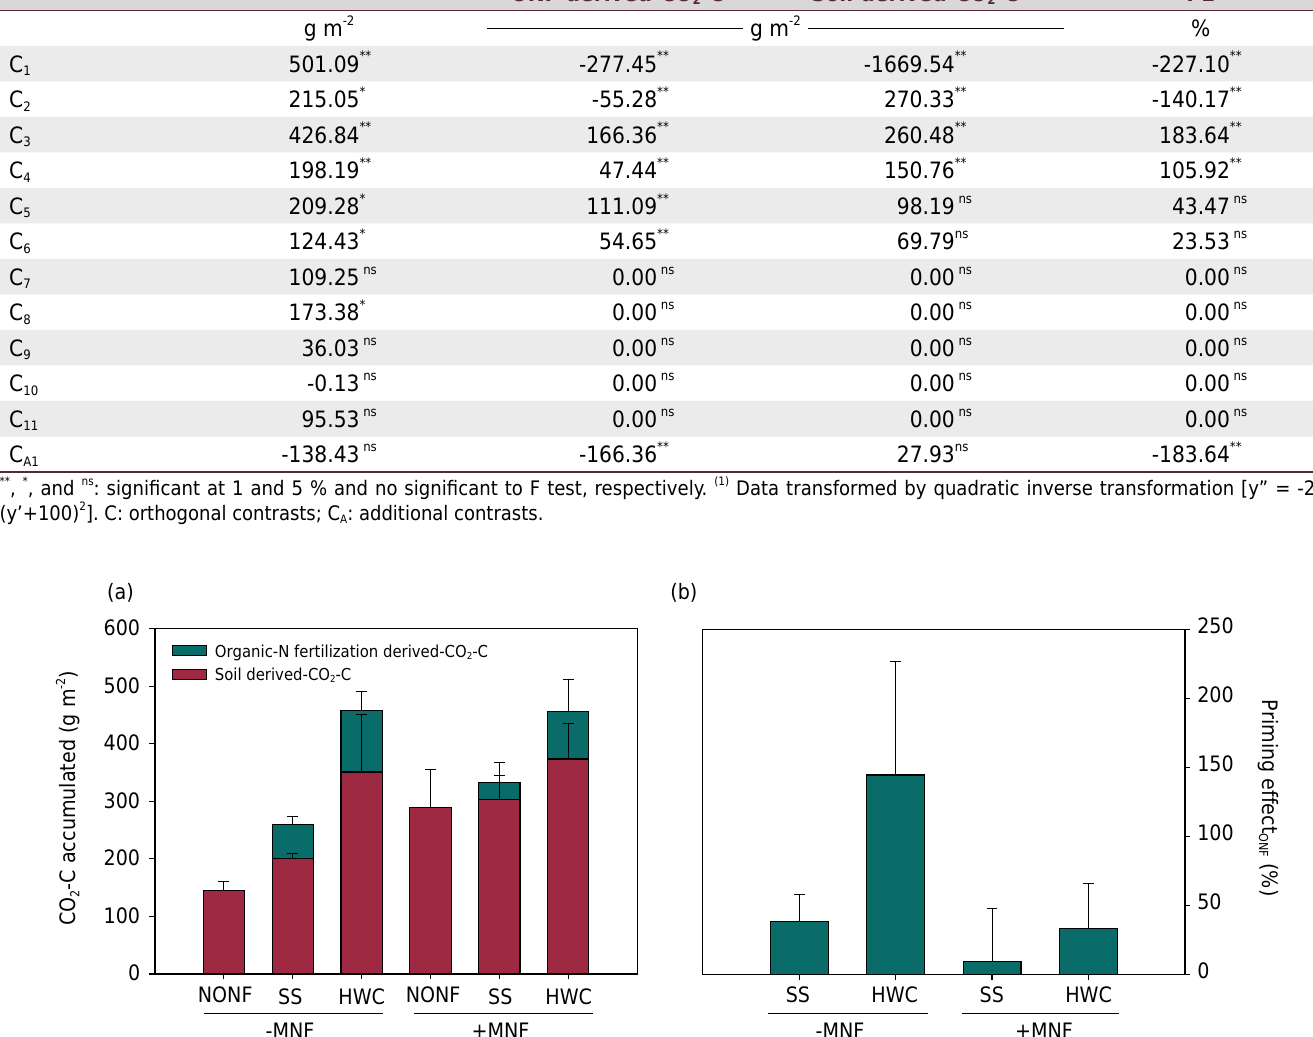
Table 4. Mean contrasts to total soil CO 2 -C accumulated and organic-N fertilization derived-CO 2 -C (ONF derived-CO 2 -C) and soil derived-CO 2 -C to the soil without plant (-Plant) Contrasts